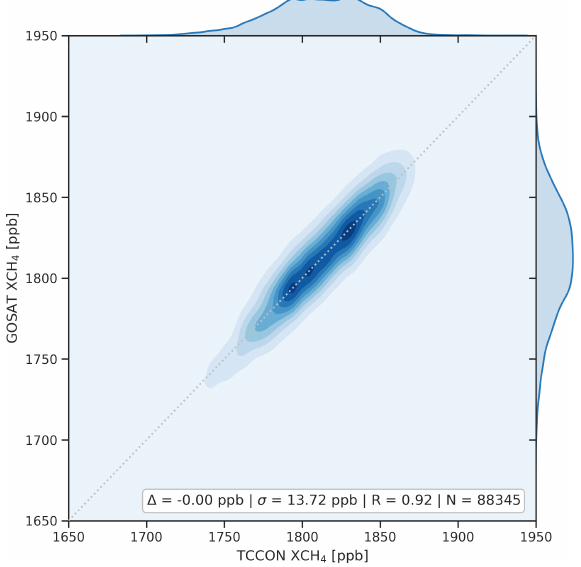
Figure 7. Correlation between the 88345 matching TCCON XCH 4 data and co-located GOSAT Proxy XCH 4 measurements across all TCCON sites. The data are presented as a two-dimensional ker- nel density estimation (KDE) plot. The distribution sites along the one-to-one line (grey dashed) with a standard deviation (i.e. single- sounding precision) of 13.72ppb and a correlation coefficient ( R ) of 0.92. An overall bias to TCCON of 9.06ppb is removed from the GOSAT data, resulting in an average bias of 0ppb by design. The individual KDE plots are shown along the upper and right margins.